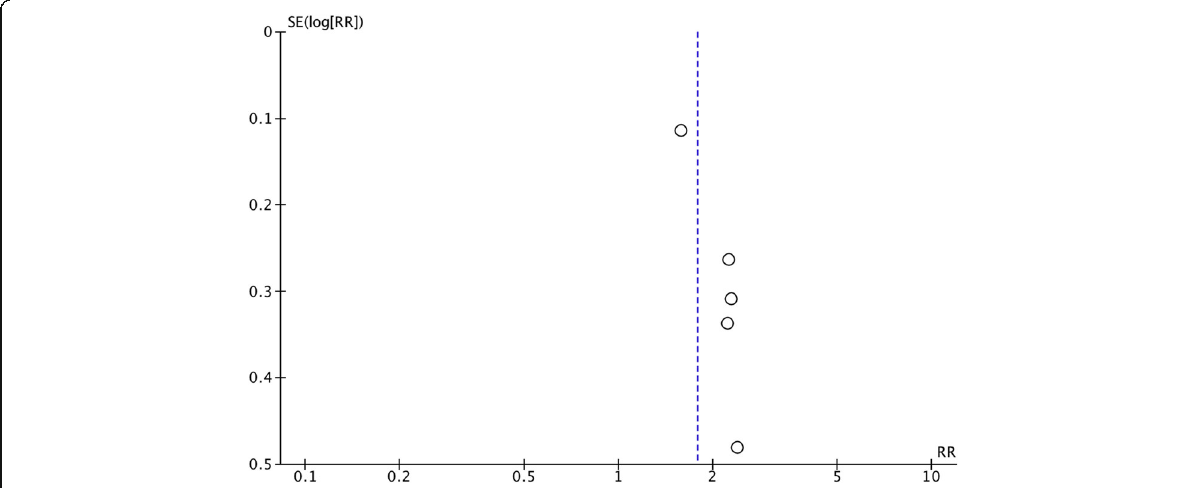
Fig. 12 Funnel plot summarizing the five studies reporting on the primary outcome. The vertical dotted line indicates the overall pooled effect measure (Relative